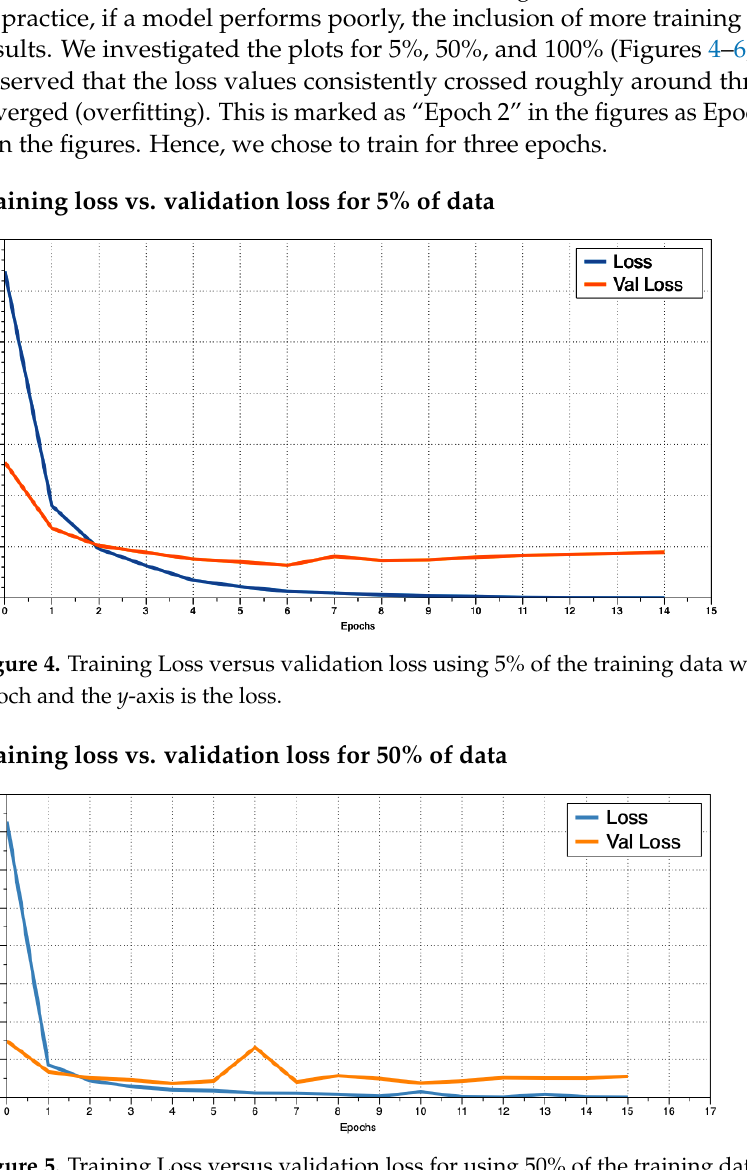
Figure 5. Training Loss versus validation loss for using 50% of the training data where the x -axis is the epoch and the y -axis is the